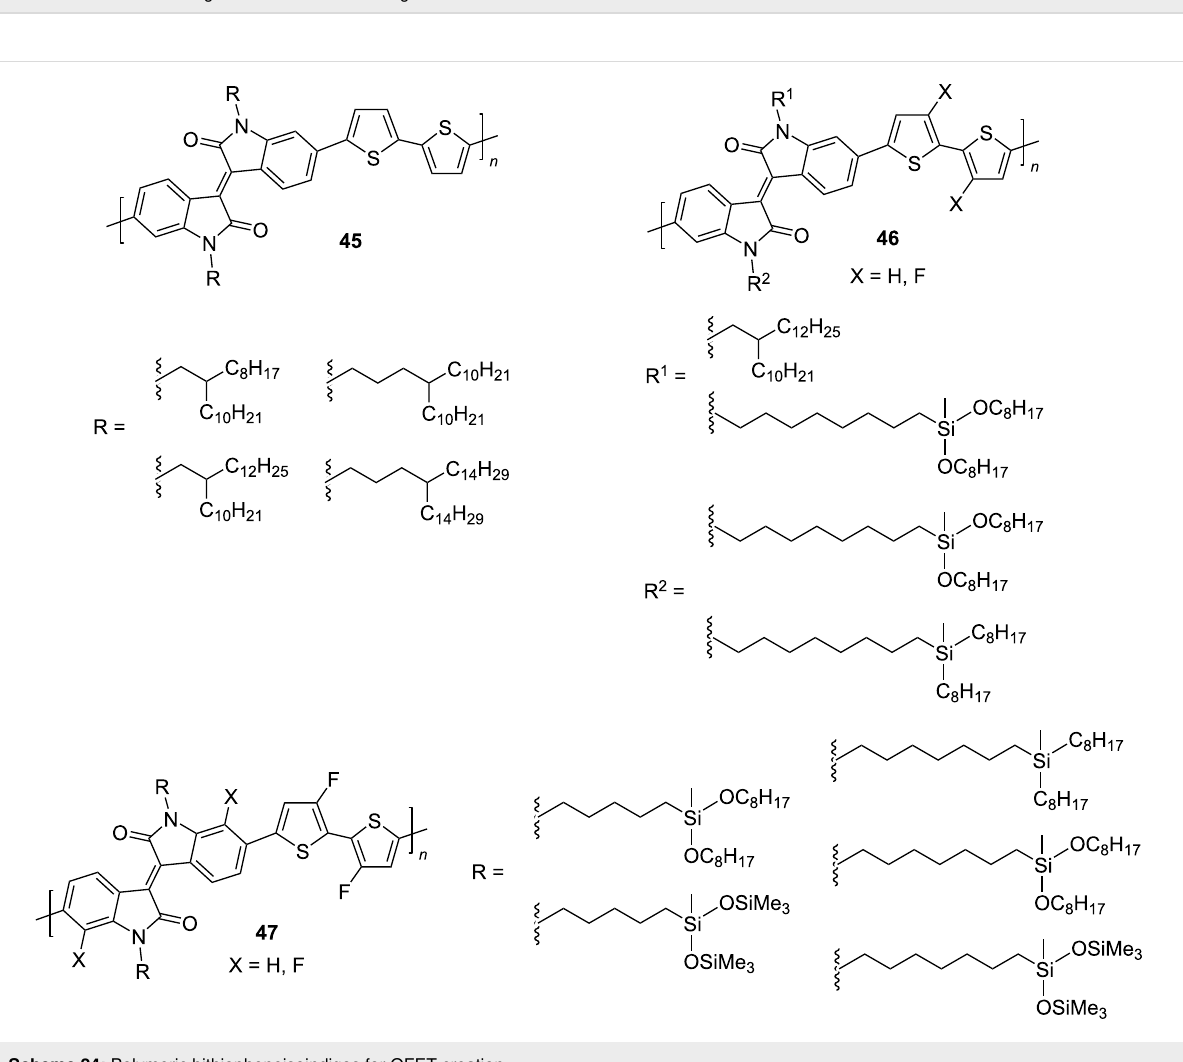
Scheme 24: Polymeric bithiopheneisoindigos for OFET